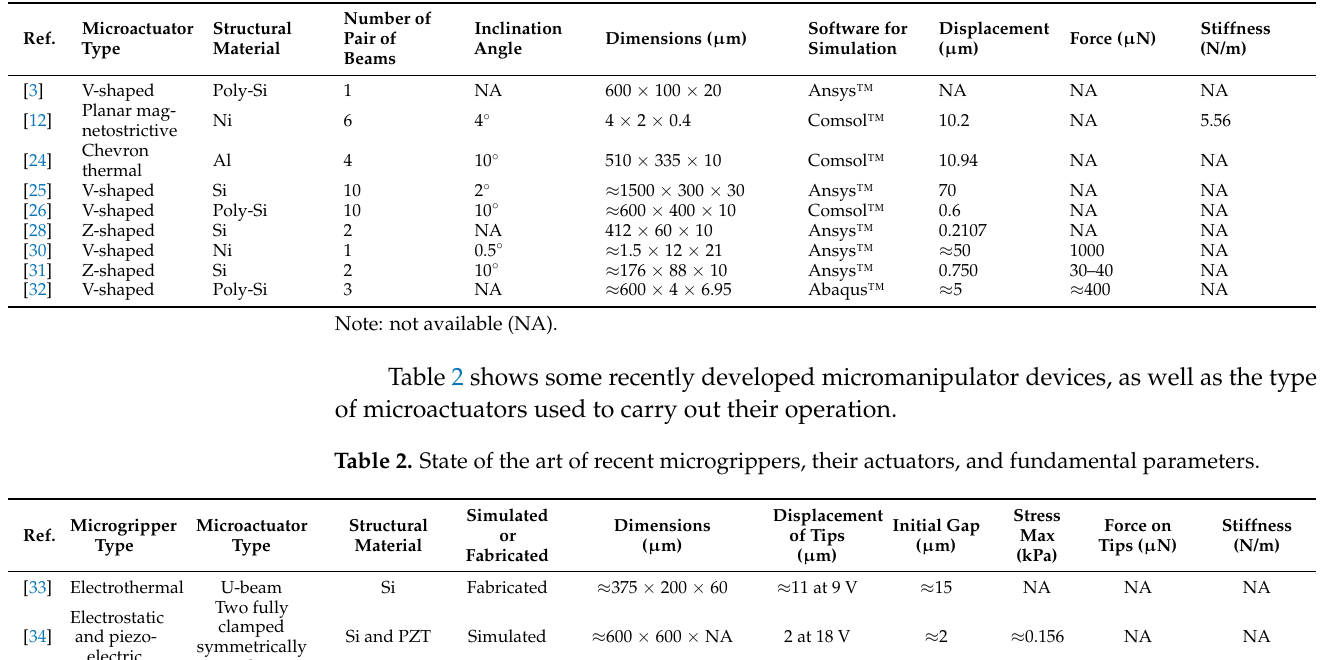
Table 1. State of the art of recent V- and Z-shaped beam microactuators, and some of their fundamental parameters.